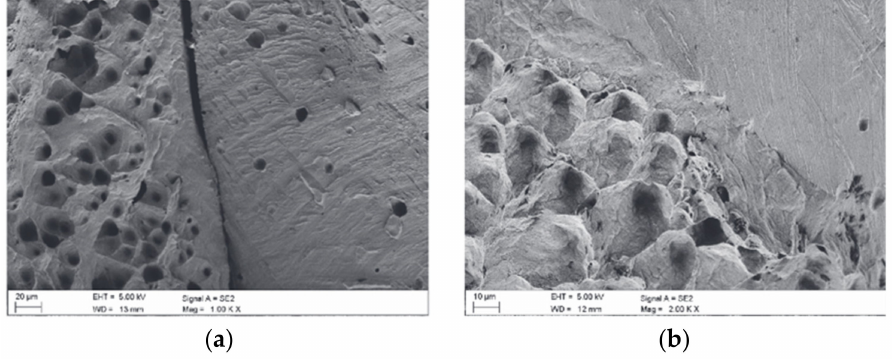
Figure 10. Fracture surface at temperature ( a ) 150 ◦ C; ( b ) 250 ◦ C